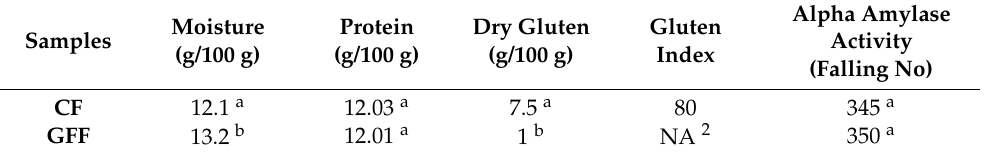
Table 1. Chemical composition of control flour (CF) and Gluten Friendly™ flour (GFF) 1 .